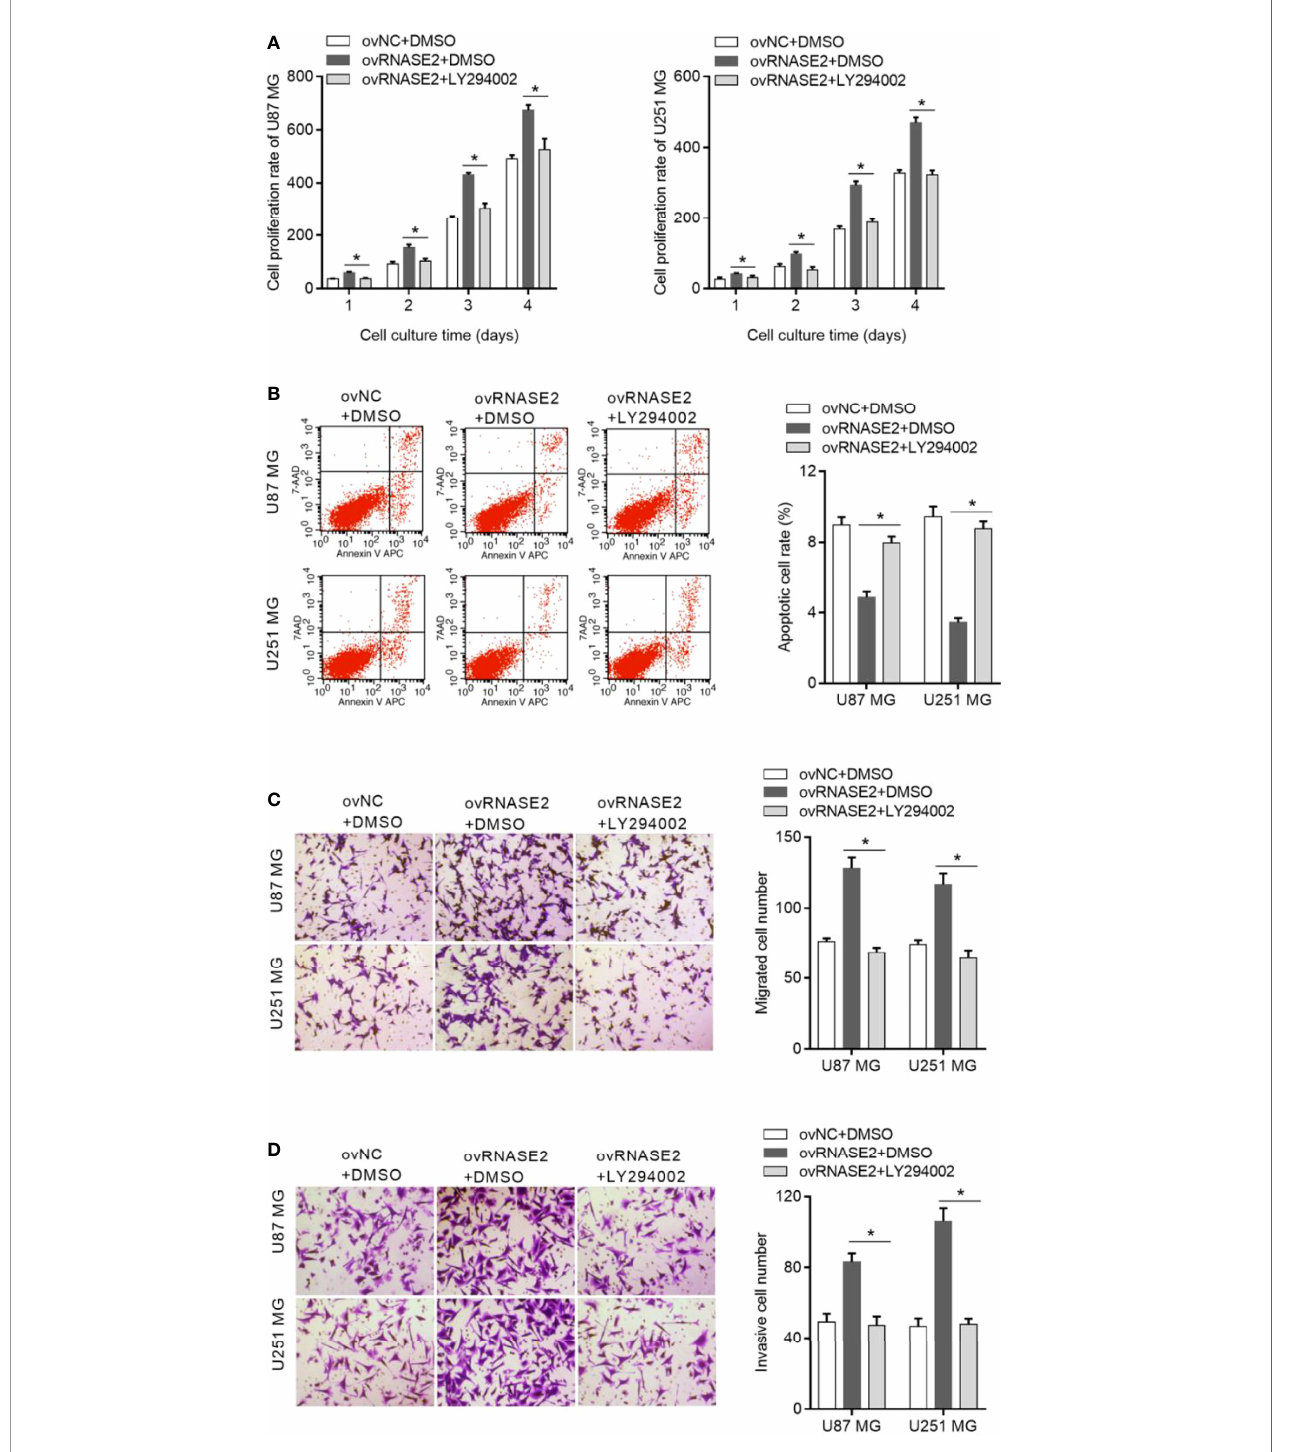
FIGURE 6 | LY294002, a PI3K inhibitor, blocks the effect of RNASE2 overexpression on the function of U87 MG and U251 MG cells. LY294002 was used to treat cells overexpressing RNASE2 (ovRNASE2+LY294002). DMSO-treated cells were used as a control (ovNC+DMSO, ovRNASE2+DMSO). LY294002 alleviated the effect of RNASE2 overexpression on proliferation (A) , apoptosis (B) , migration (C) , and invasion (D) . * indicates p < 0.05; ovRNASE2+LY294002 versus